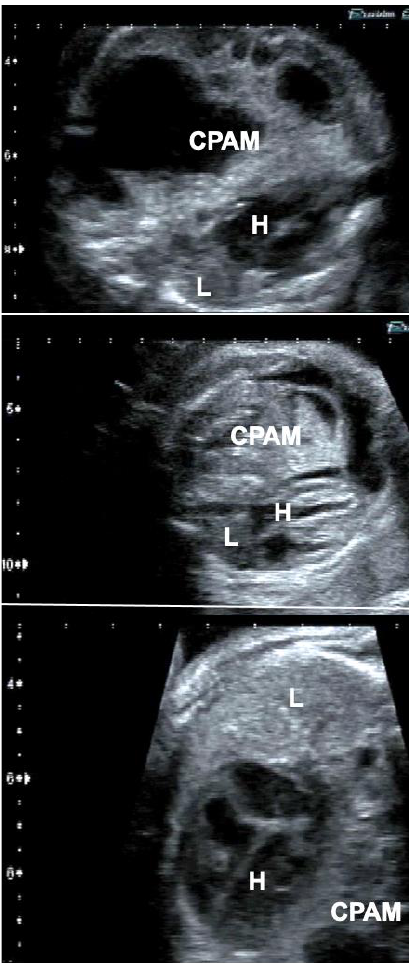
Figure 6. Effect of FETO in a fetus with a giant congenital pulmonary airway malformation (CPAM) ( top ), whose lungs did not distend — despite several previous interventions — after long-standing compression and were considered too small or too dysfunctional for postnatal survival ( middle ). In this case, FETO at 30 + 4 weeks of gestation served as the last resort to achieve lifesaving lung catch-up growth ( bottom ). H = heart; L = lung.